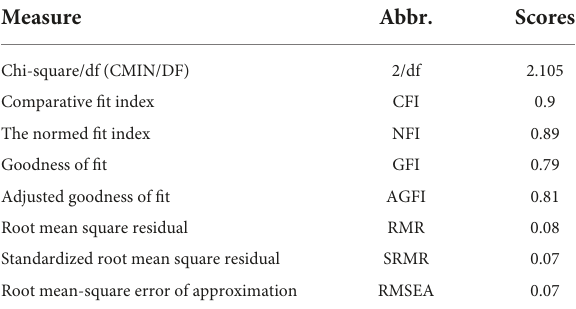
TABLE 3 Fit indicates of CFA model.